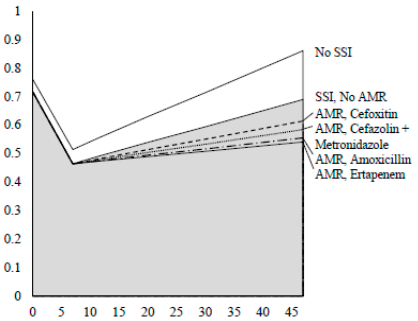
Figure 2. Utility values by day of hospital stay according to the outcomes considered in the cost-effectiveness analysis: no infection, surgical site infection (SSI), and antimicrobial resistant infection (AMR-SSI), per antimicrobial prophylaxis strategy. “SSI”: surgical site infections; “AMR”: antimicrobial resistant microorganisms.